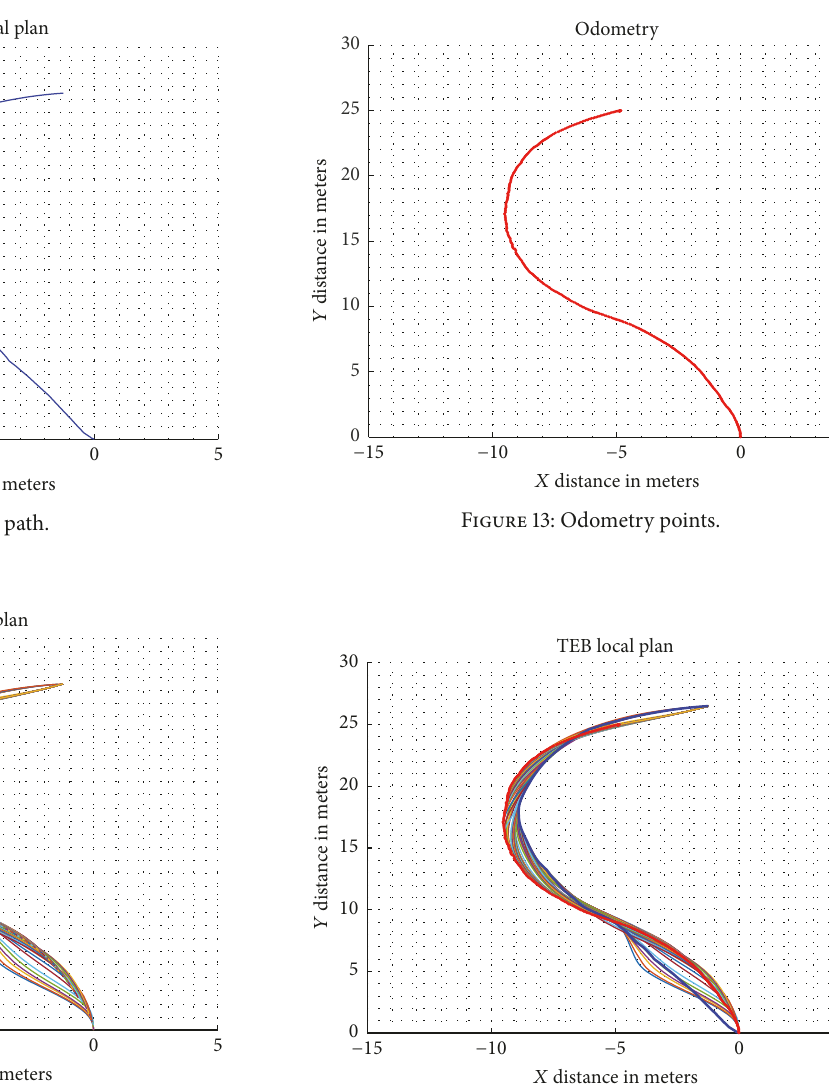
Figure 12: Local path.